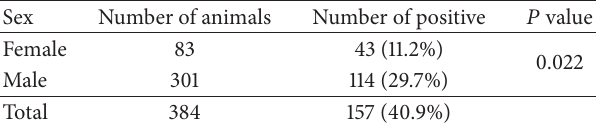
Table 3: Prevalence of Haemonchus in sheep based on the sex.